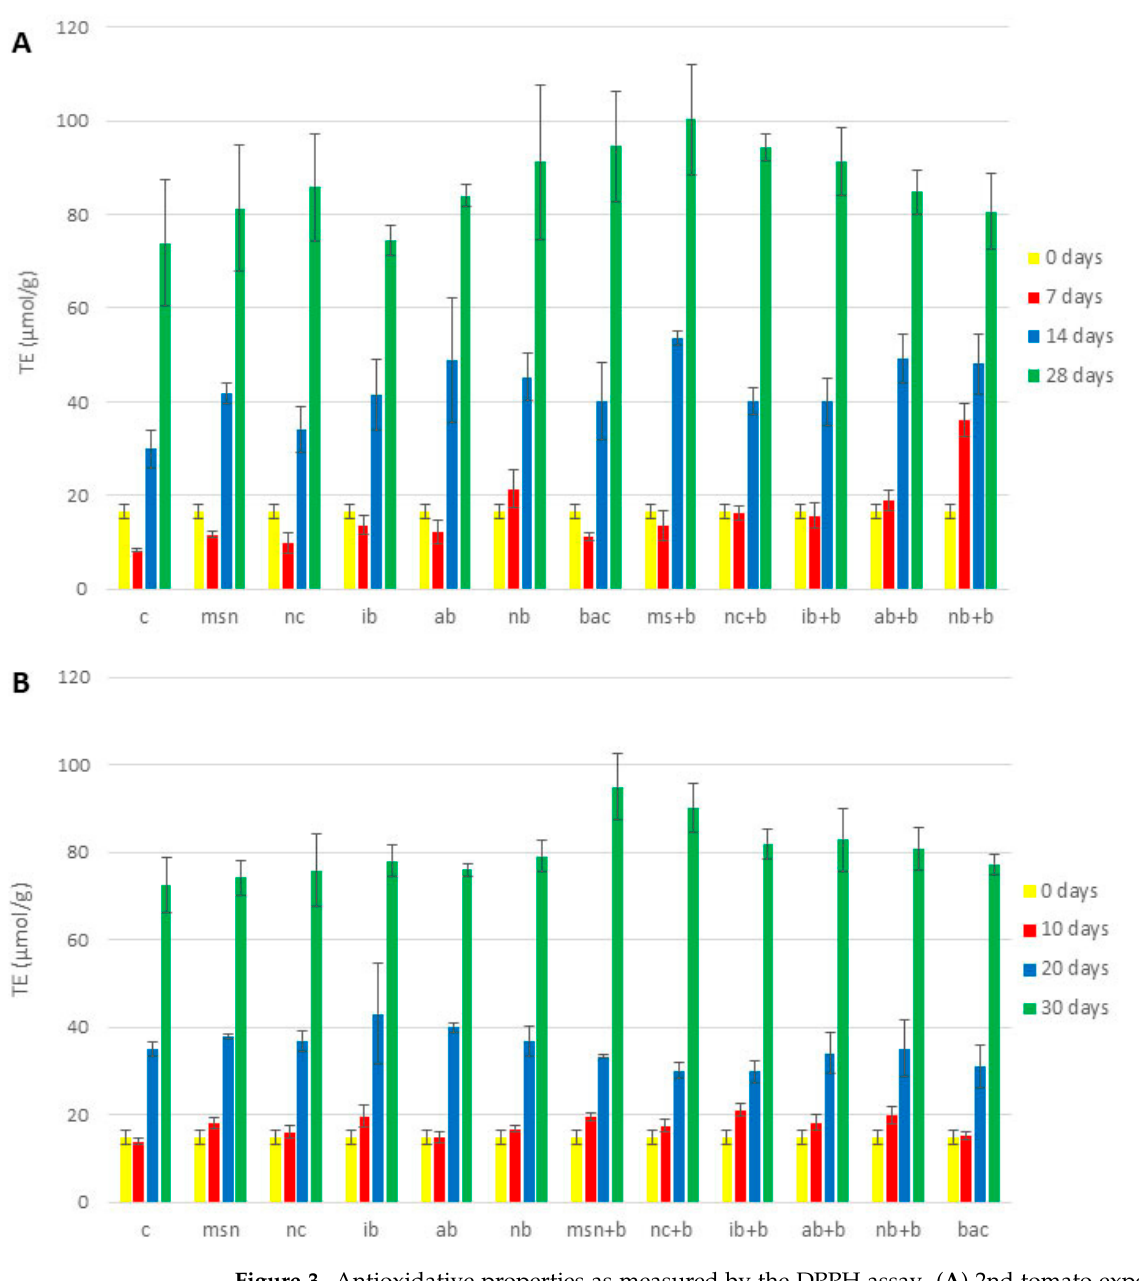
Figure 3. Antioxidative properties as measured by the DPPH assay. ( A ) 2nd tomato experiment; ( B